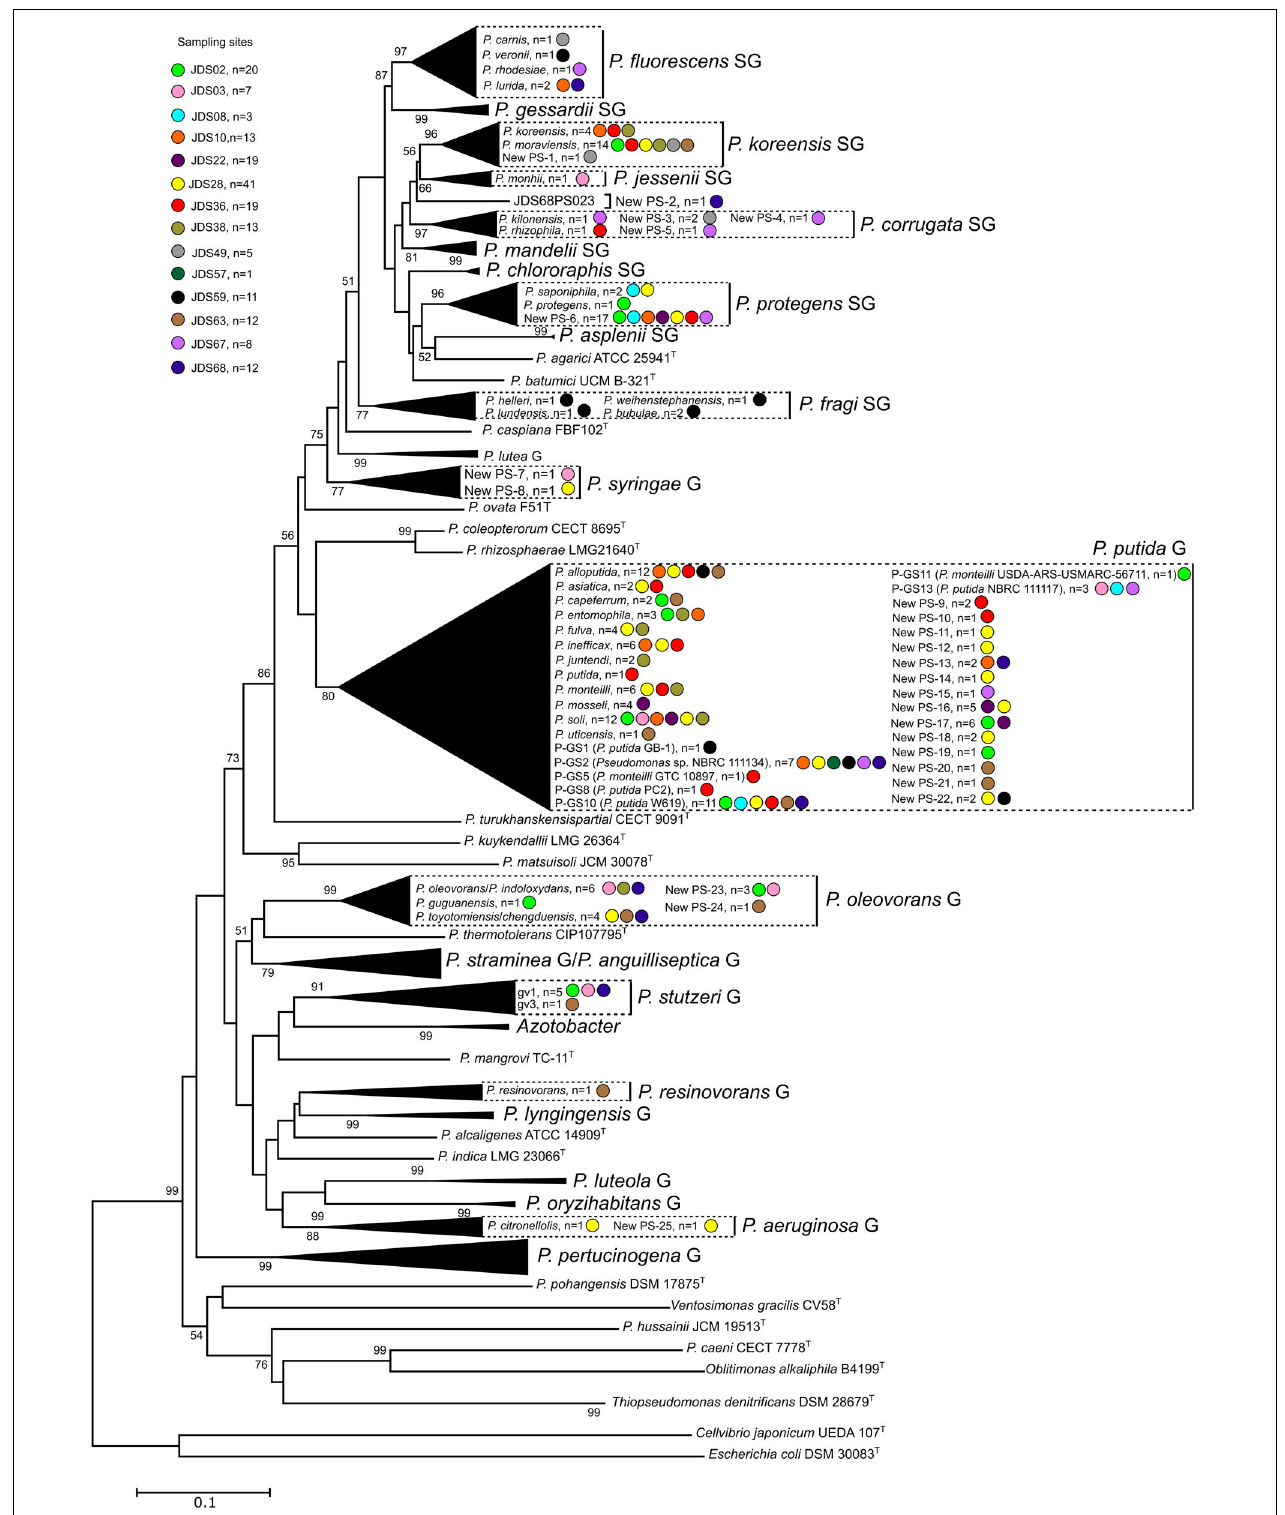
FIGURE 2 | Phylogenetic relationships of the 190 selected strains based on the partial rpoD gene sequence analysis. Colored dots indicate the sampling site and “n” the number of strains. Distance matrices were calculated by the Jukes-Cantor evolutionary model (Jukes and Cantor, 1969). Dendrograms were generated by the neighbor-joining method. Cellvibrio japonicum UEDA 107 T was used as the outgroup. The bar indicates sequence divergence. Percentage bootstrap values of more than 50% (from 1000 replicates) are indicated at the nodes.